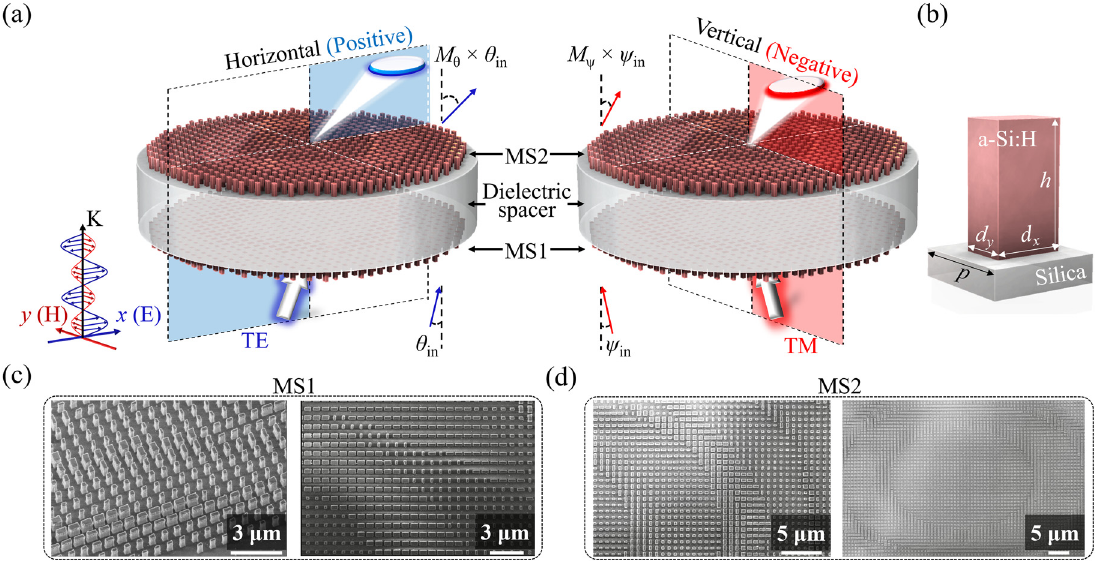
Figure 1: Configuration of the proposed FTS. (a) Illustrations of beam deflection mediated by the MD-based FTS under TE and TM polarization at a wavelength of 1550 nm. (b) Con fi guration of the designed a-Si:H nanopost formed on a silica substrate constituting the meta-atoms. (c) and (d) SEM images of the fabricated MS1 and MS2,